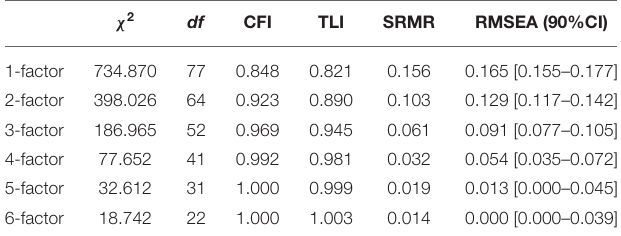
TABLE 1 | Model fit for EFA (14